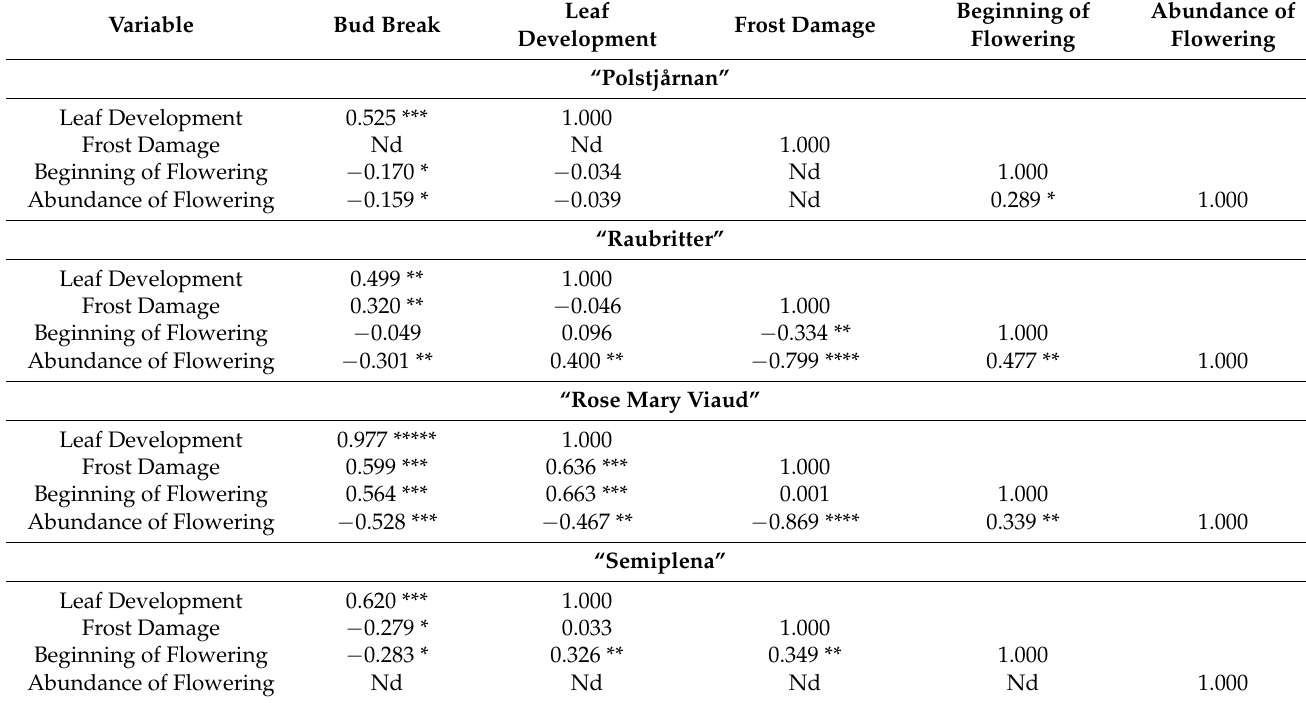
Table 9. Correlation matrices between frost damage, early phenology stages, the beginning of flowering, and its abundance in rambler roses: “Polstjårnan”, “Raubritter”, “Rose Mary Viaud”, “Semiplena”, “Turner’s Crimson Rambler”, “Veilchenblau”, and